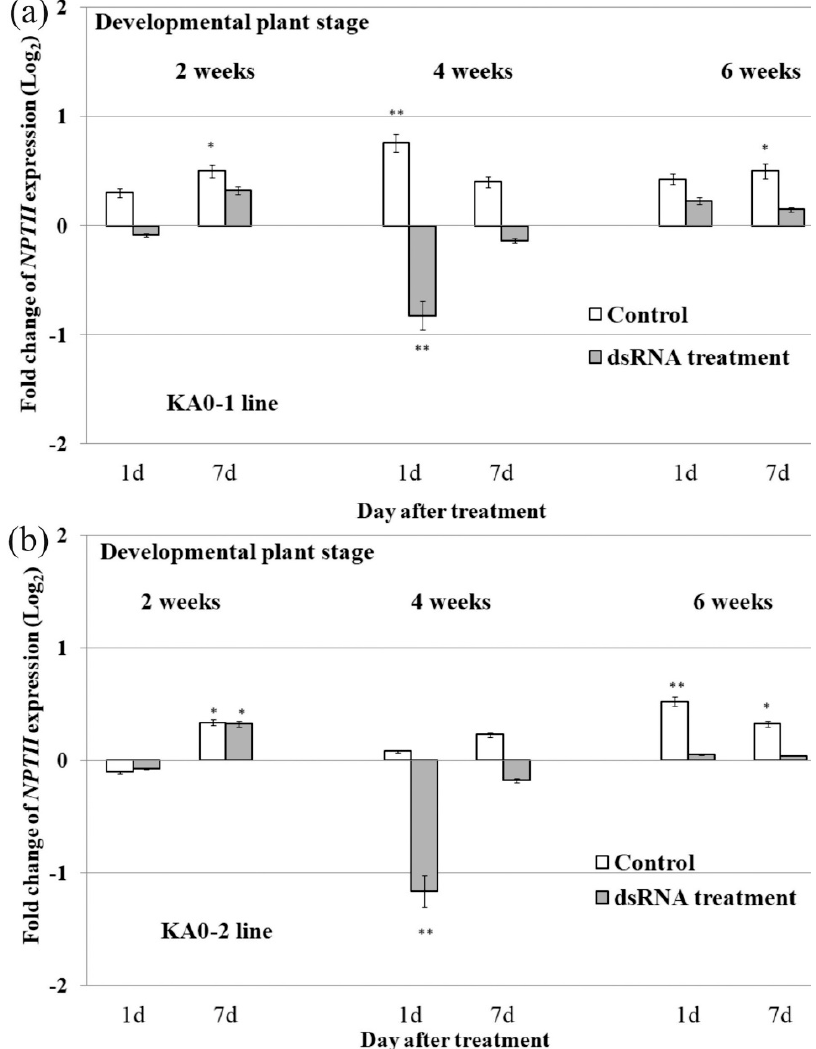
Figure 1. The effect of plant age on the dsRNA-induced NPTII downregulation in Arabidopsis thaliana . Quantification the NPTII mRNAs (log 2 ) in the KA0-1 ( a ) and KA0-2 ( b ) lines of A. thaliana in response to foliar application of sterile filtered water (control water treatment) or NPTII -encoding dsRNA (dsRNA treatment) relative to NPTII mRNA level in A. thaliana before treatments. The abaxial and adaxial surfaces of the leaves were treated by sterile soft brushes with 0.35 µg/µL of NPTII - ds RNA or water (100 µL per individual treatment). dsRNA was applied to an individual 4- or 6-week-old plant and to three 2-week-old individuals in an independent experiment. qRT-PCR data are presented as mean ± SE (two independent experiments). *, **—significantly different from the values in plants before treatments at p ≤ 0.05 and 0.01, respectively, according to the Student’s t -test.